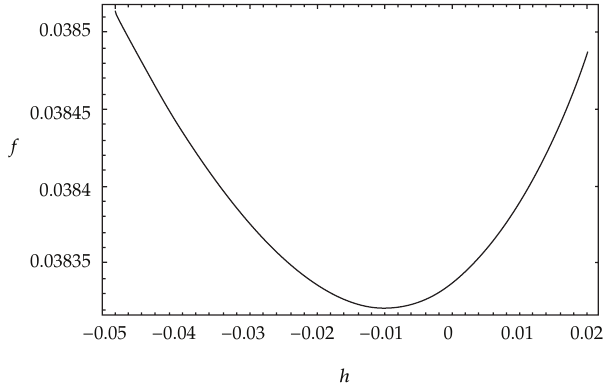
Figure 6: Residual error curve for variable